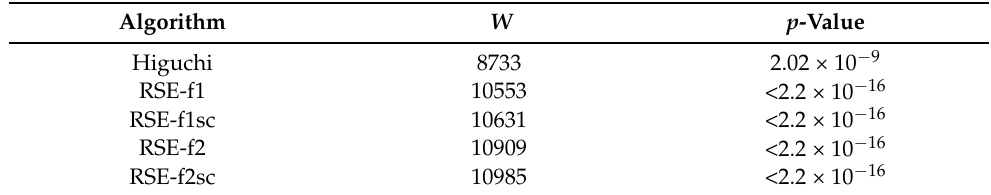
Table 3. Willcoxon Two-sample Rank sum test results between the different groups (raw and denoised signals).